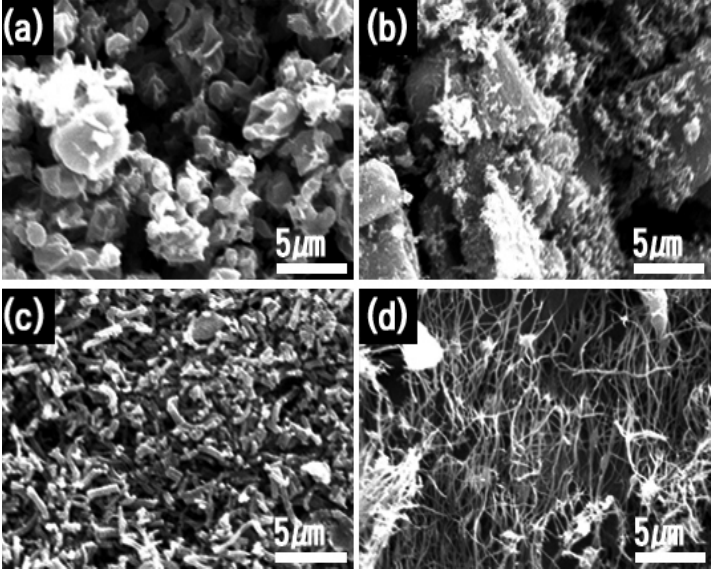
Figure 3. FESEM images of calcined samples; ( a ) S1(800), ( b ) S2(800), ( c ) S4(800) and ( d ) S5(800).